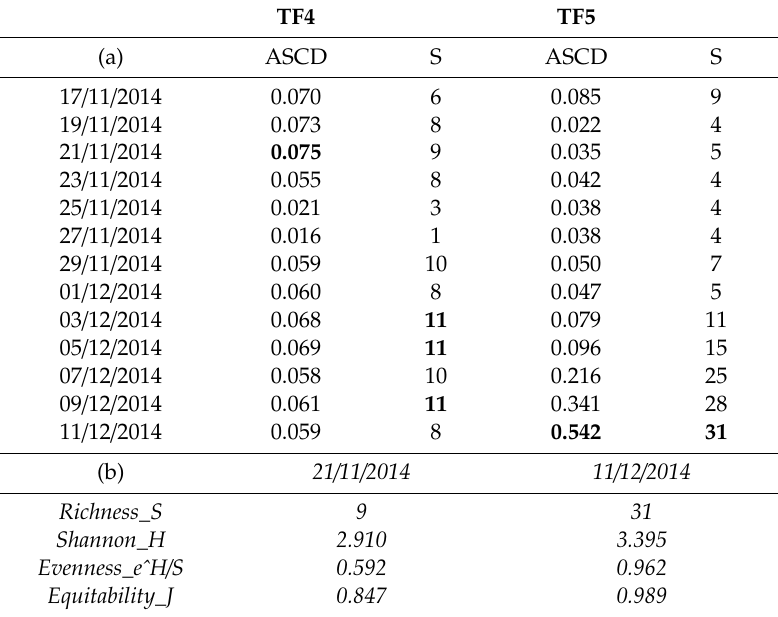
Table 2. The raw substrate utilization with absorbances over 0.10 OD recorded at plate level, referred to as averaged substrate color development (ASCD) with time, and the number of positive wells (S) (a). The diversity measures of substrate utilization of the brine samples determined at the time of maxima ASCD value (b).